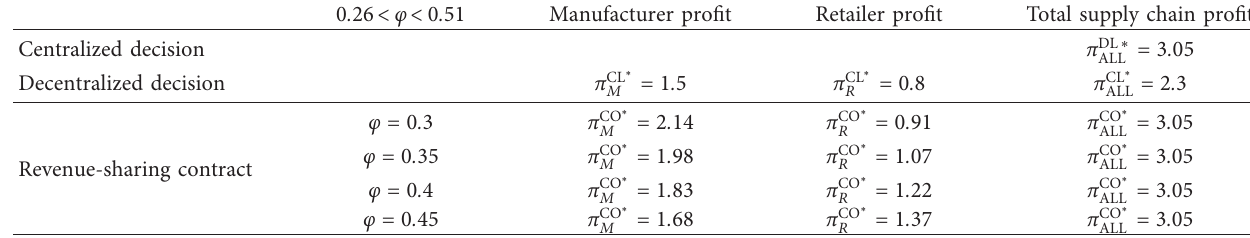
Figure 4: The impact of consumer heterogeneity on profits in the supply chain: (a) manufacturers’ profits, (b) retailers’ profits, and (c) the total profits of supply chain. Table 1: Profit comparison of members under decentralized decision, centralized decision, and coordination mechanism. 0 . 26 < φ < 0 . 51